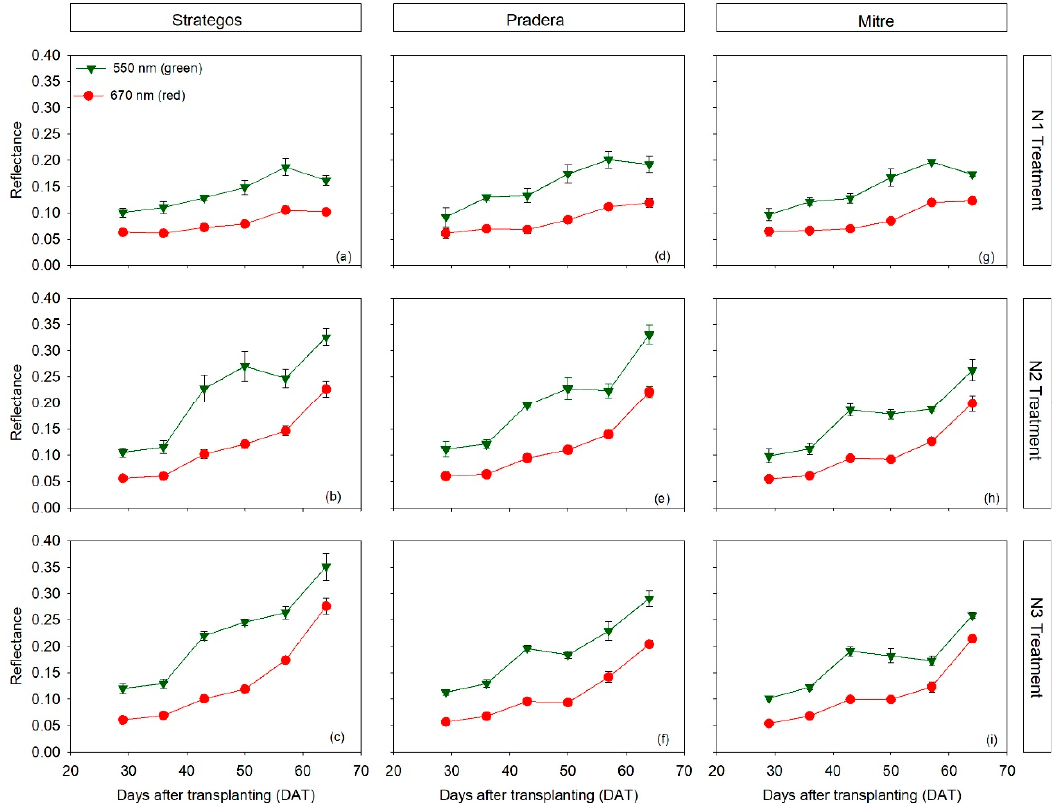
Figure 3. Temporal dynamics of red and green reflectance of three cultivars of cucumber ( Cucumis sativus L. ‘Strategos’ (panels a – c ), ‘Pradera’ (panels d – f ) and ‘Mitre’ (panels g – i )) under three N treatments (N1, N2 and N3). Values are means ± SE.